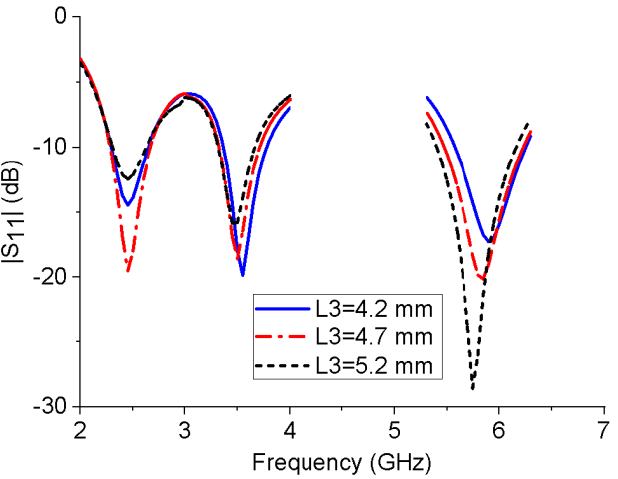
Figure 4. Reflection coefficients of the monopole antenna with different L3 values.